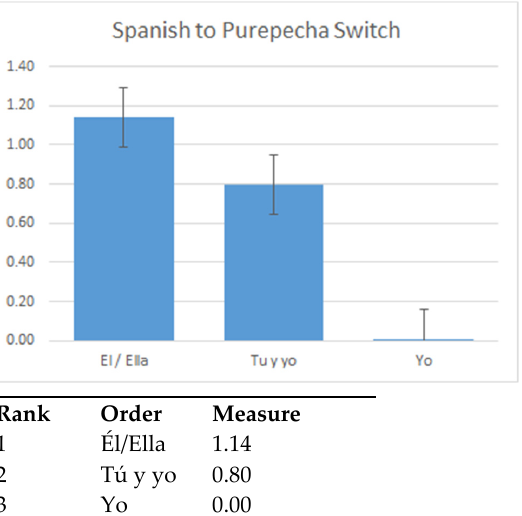
Figure 1. Rank ordering of 2AFC results for Spanish to P’urhepecha switches (above), including the measure of Thurstone’s analysis (below).